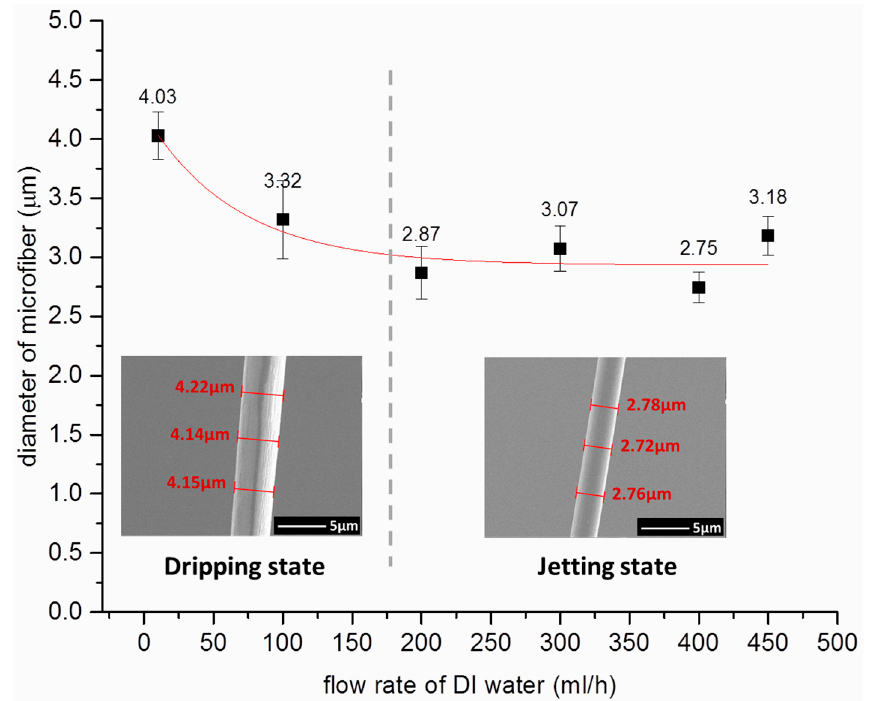
Figure 4. Influence of deionized (DI) water flow rate on the diameter of microfiber. The insets are the scanning electron microscope (SEM) images of uniform microfibers with different diameters.